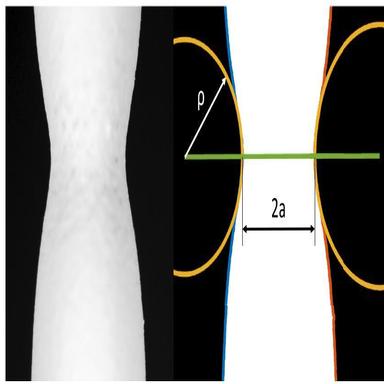
Representation of the necked specimen obtained in the condition of εT = 1.3 for a stainless steel 304L specimen. The neck shape, minimum diameter (2a) and osculating circles are shown.